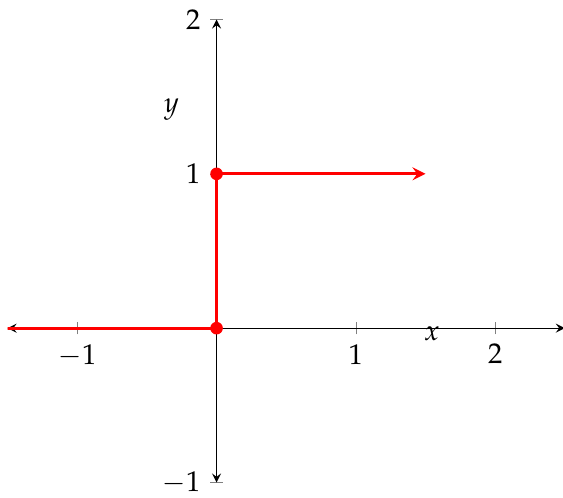
Figure 2. Step function (not